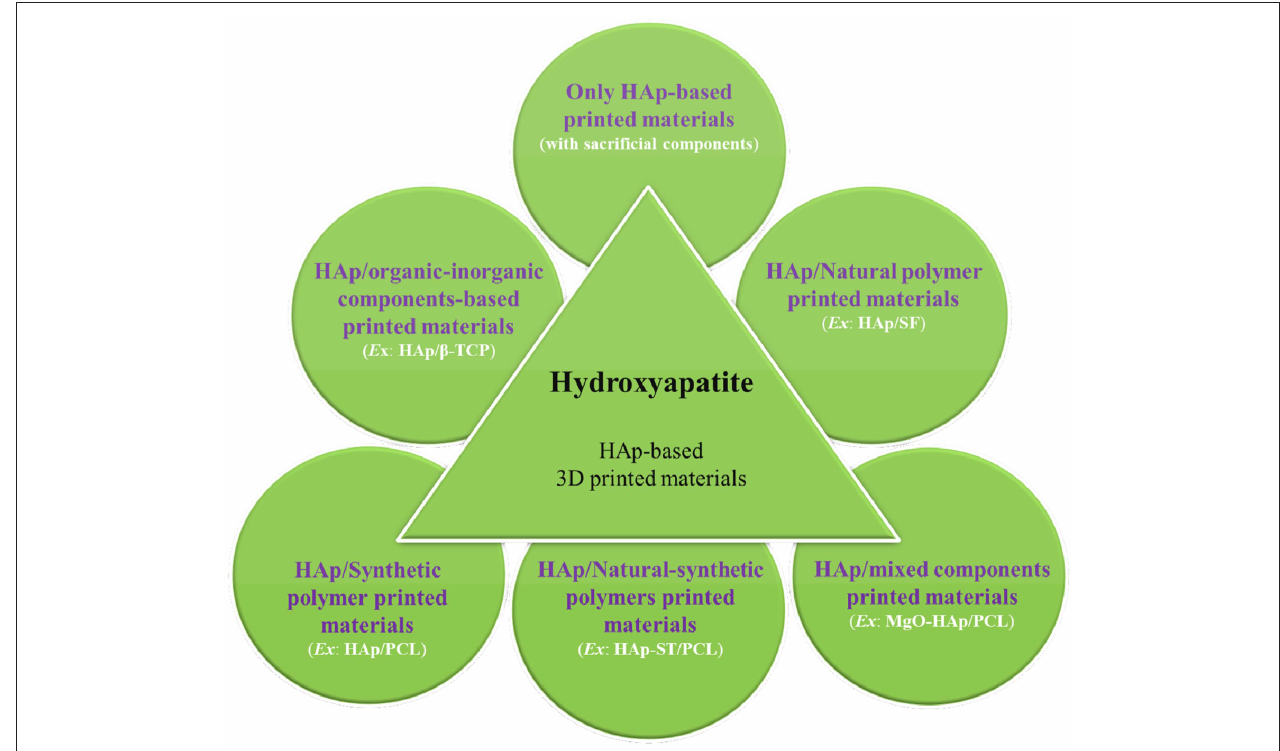
FIGURE 4 | Schematic of the summary of hydroxyapatite (HAp)-based printed materials for hard tissue